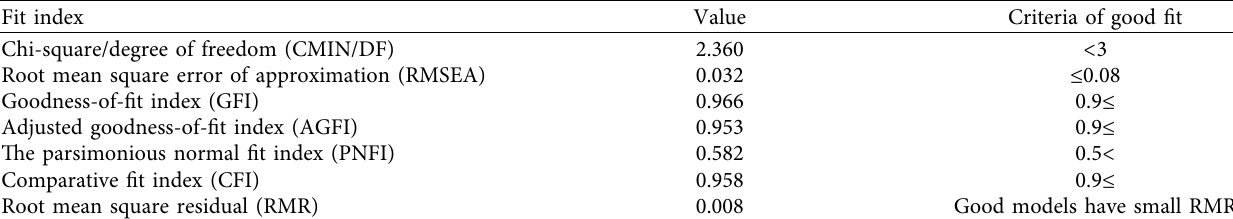
Figure 6: The graphical representation of structural equation model. Table 7: Fit statistics for structural equation model.